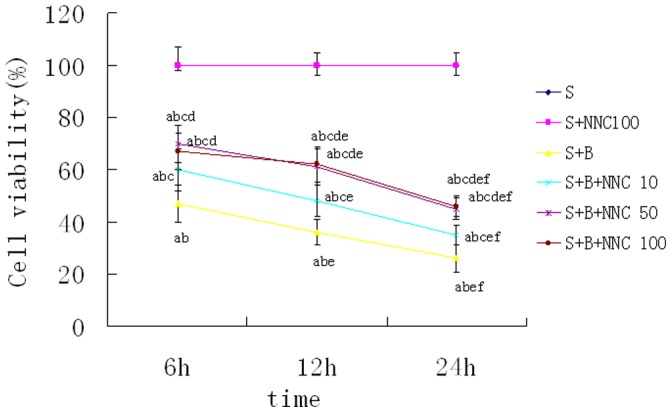
SH-SY5Y cell viability following treatment with 1 mM bupivacaine (%, mean±S.D, n = 6).
aP<0.05 vs. S group; bP<0.05 vs. S+NNC 100 group; cP<0.05 vs. S+B group; dP<0.05 vs. S+B+NNC 10 group; eP<0.05 vs. time point of 6 hours; fP<0.05 vs. time point of 12 h.